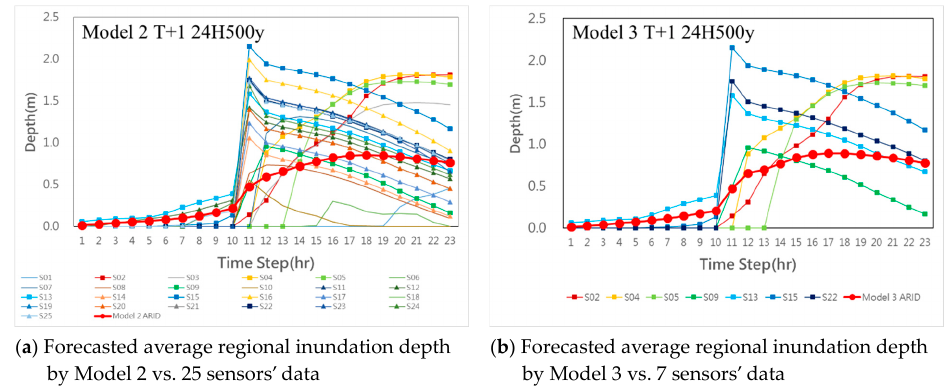
Figure 6. The sensor data vs. T + 1 forecasted average regional inundation depths by Models. ( a ) 25 sensors’ data vs. T + 1 forecasted ARIDs of Model 2; ( b ) 7 sensors’ data vs. T + 1 forecasted ARIDs of Model 3.